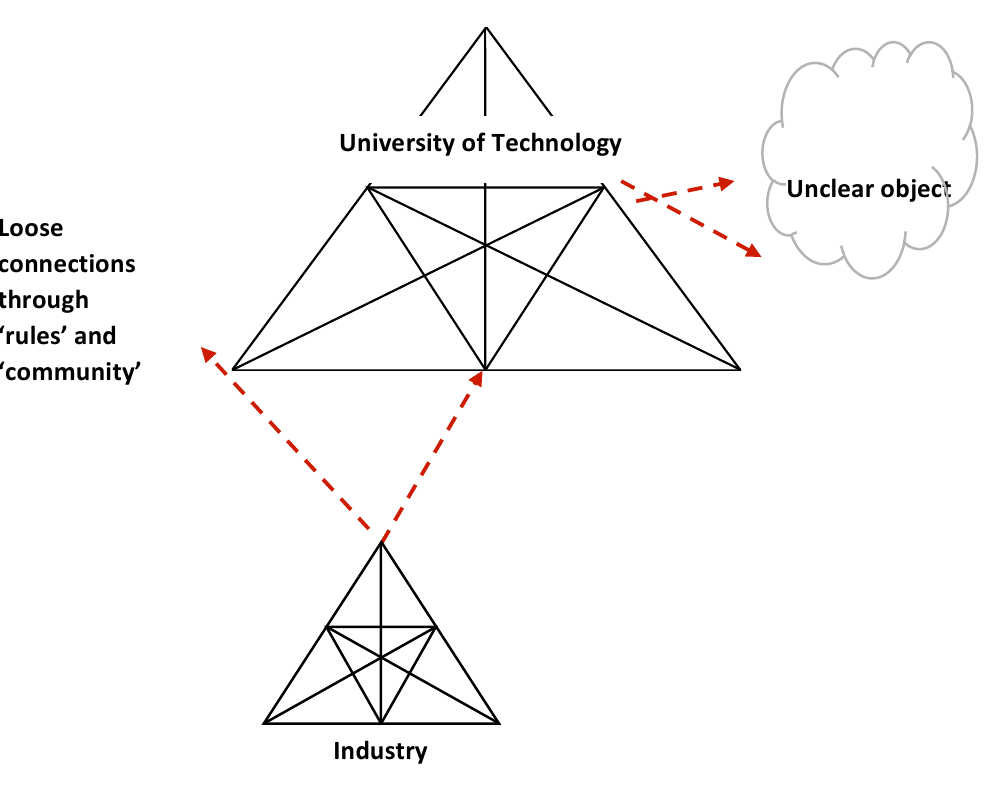
Figure 3: The aspirational University of